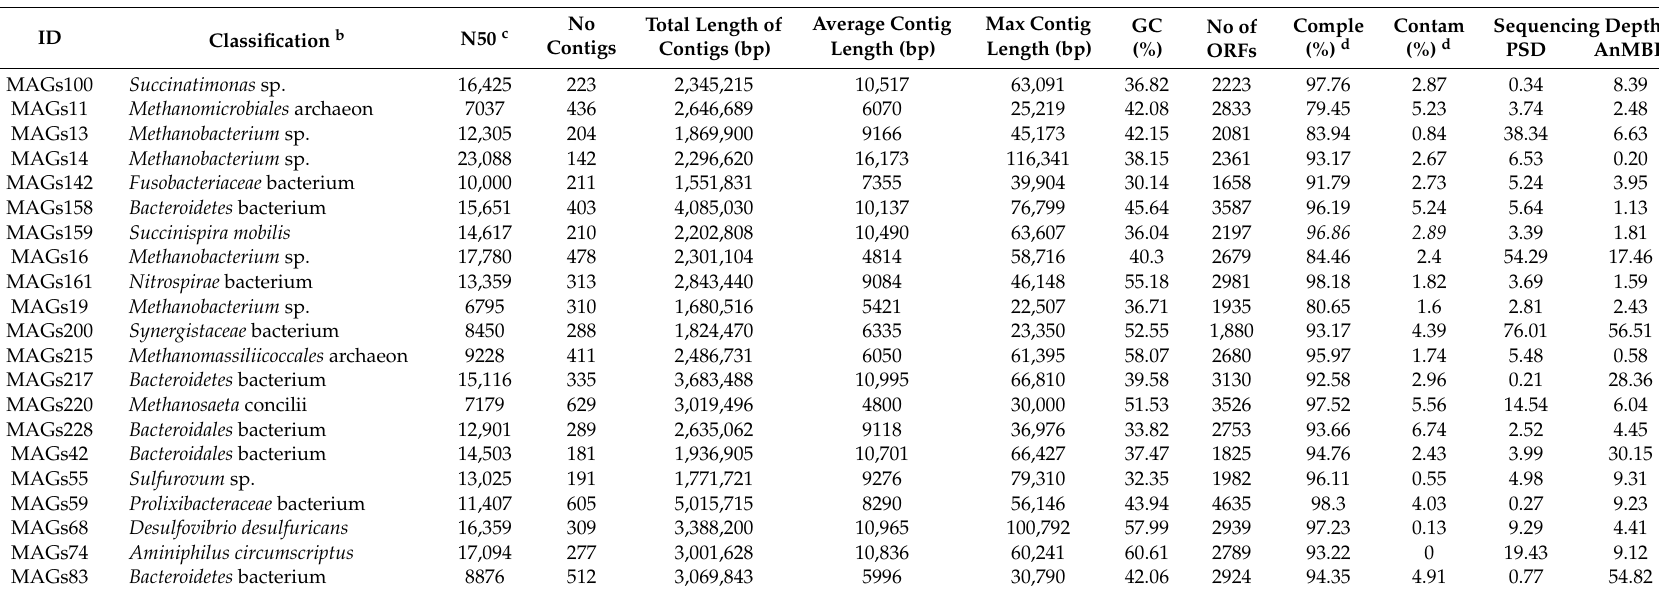
Table 2. Taxonomic assignment and basic genome characteristics of the curated MAGs reconstructed from the PSD and AnMBR metagenomes a .